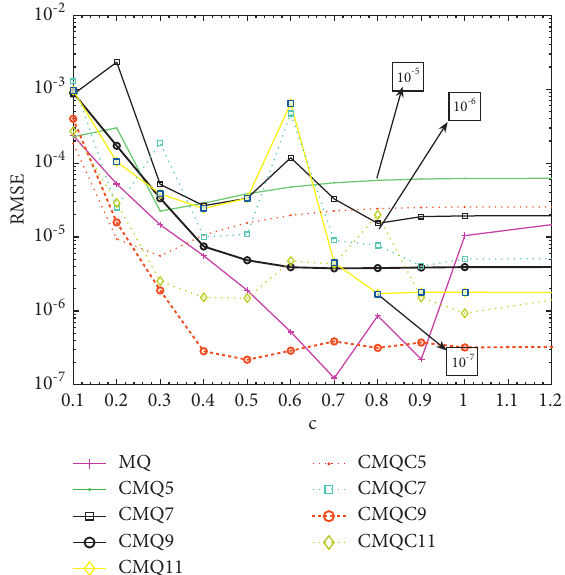
Figure 2: RMSEs for field solution versus the value of parameter c